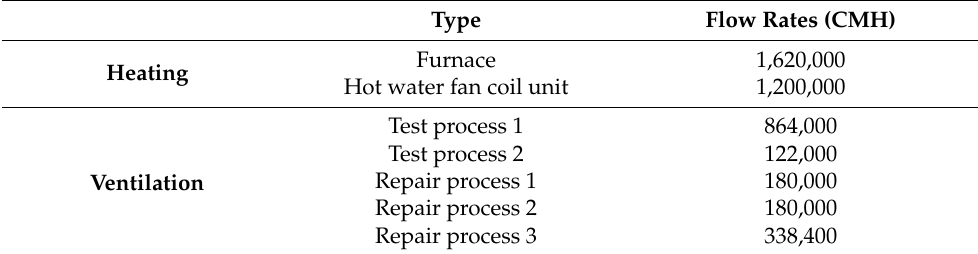
Table 1. Specification of the heating/ventilation facilities.